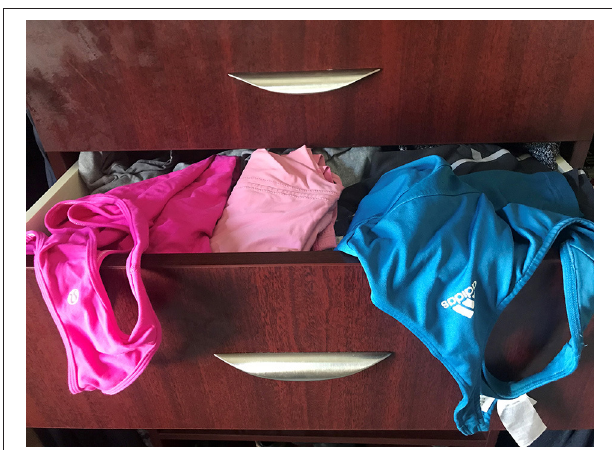
FIGURE 2 | An image of an overflowing activewear